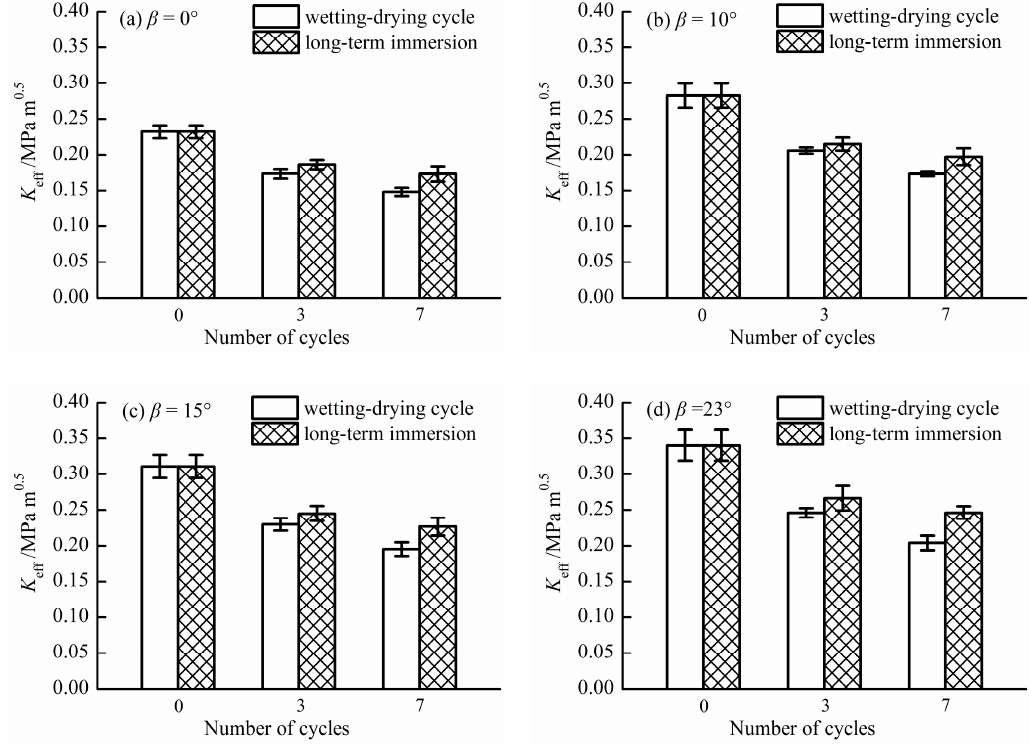
Figure 5. Effective fracture toughness of sandstone under water–rock interactions with a different number of cycles.